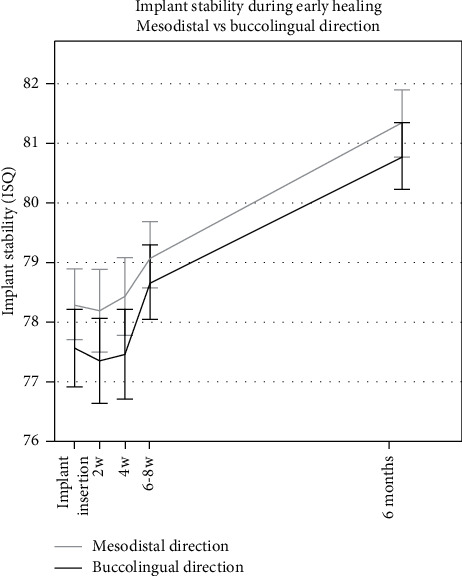
Time-stability curve for ISQ measurements taken in mesiodistal and buccolingual directions at the time of implant insertion, 2-, 4-, and 6 weeks, and 6 months. Error bars show the standard error of the mean (SEM).